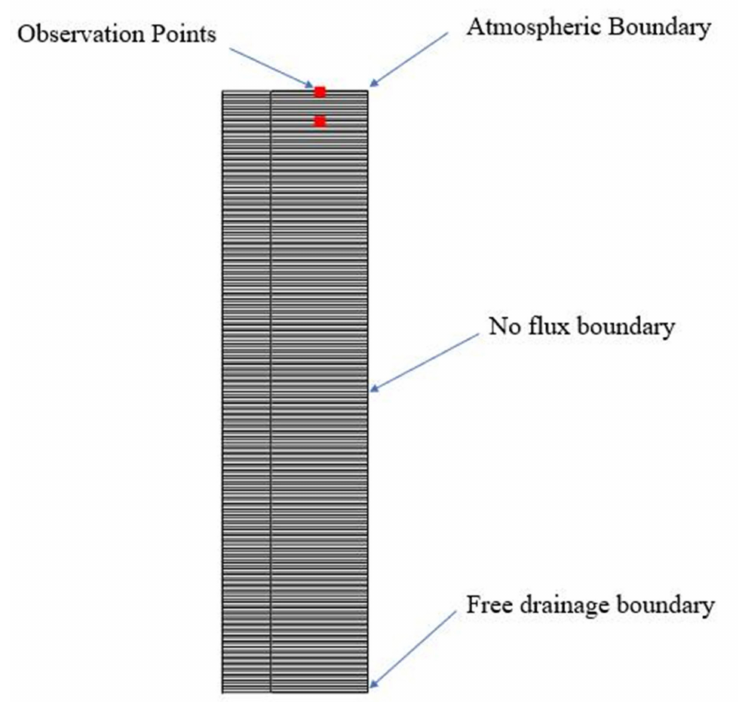
Figure 3. Soil finite element